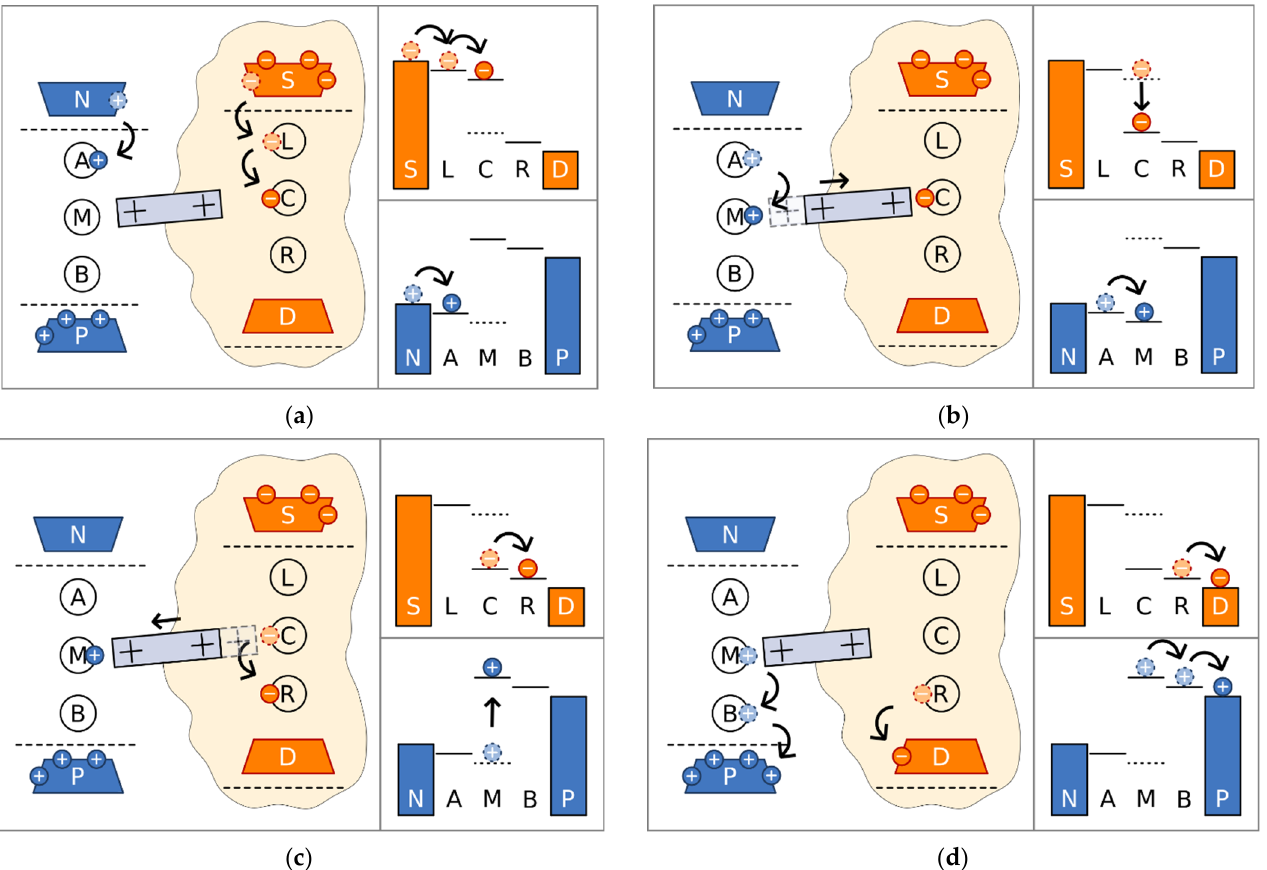
Figure 2. Piston position, sites populations, and energy levels in the sequence of events leading to the proton pumping. ( a ) Proton site A and electron site L are populated. Electron proceeds to site C . Piston is in the left position. ( b ) Piston moves to the right attracted by the electron at site C . Energies of the electron site C and proton site M decrease. Proton site M is populated. ( c ) Electron proceeds to site R releasing the piston. Piston moves to the left increasing the energy of the proton site M . ( d ) Proton proceeds to the site B and to the positive side of the membrane. Electron proceeds to the drain reservoir.